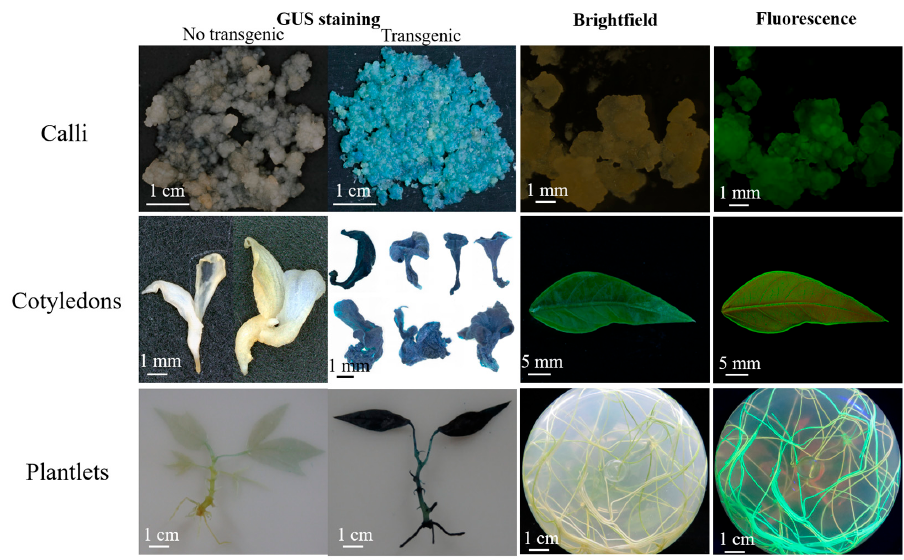
Figure 5. Agrobacterium -mediated genetic transformation of cassava SC8 FECs. ( A ) In vitro shoot culture; ( B ) axillary bud; ( C ) primary SEs on CIM medium; ( D ) SEs on CIM medium; ( E ) friable embryogenic calli on GD medium; ( F ) Agrobacterium -infected FECs proliferating on GD medium; ( G ) developing cotyledons on MSN medium; ( H ) cotyledons on CEM medium; ( I ) developing shoots on COM medium; ( J ) transgenic plantlets on MS medium; ( K ) rooting assay of transgenic plants on MS + 50 mg/L carbenicillin + 10 mg/L hygromycin; ( L ) transgenic plants in the soil.